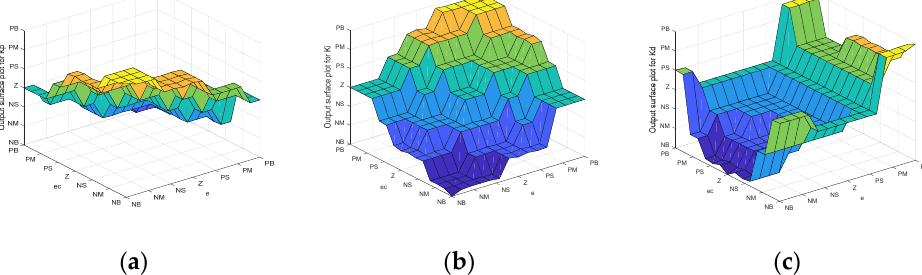
Figure 8. The three ‐ dimensional output surface of the fuzzy control output variables: ( a ) K P output surface; ( b ) K I output surface; ( c ) K D output surface. Table 2. ∆ K I fuzzy control rules.